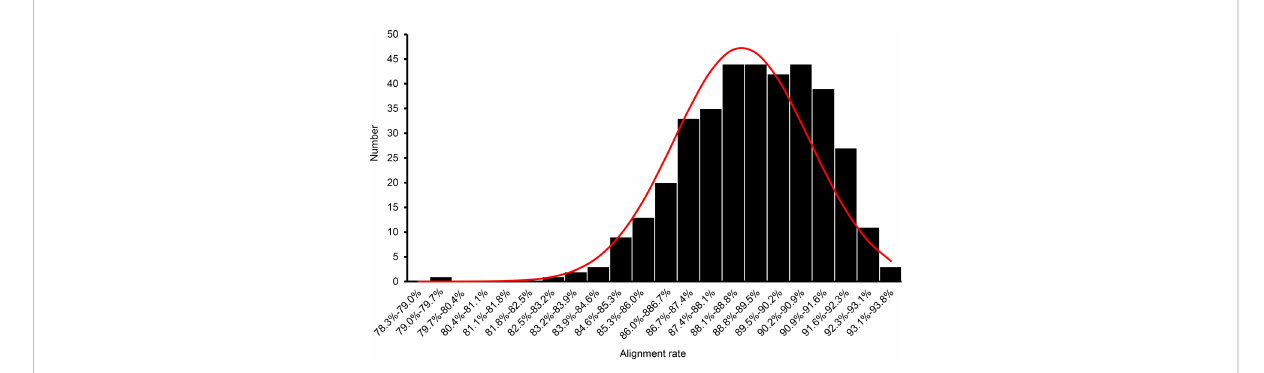
FIGURE 1 Frequency distribution of the percentage of raw genotyping-by-sequencing reads of the F 2 population mapped to the reference